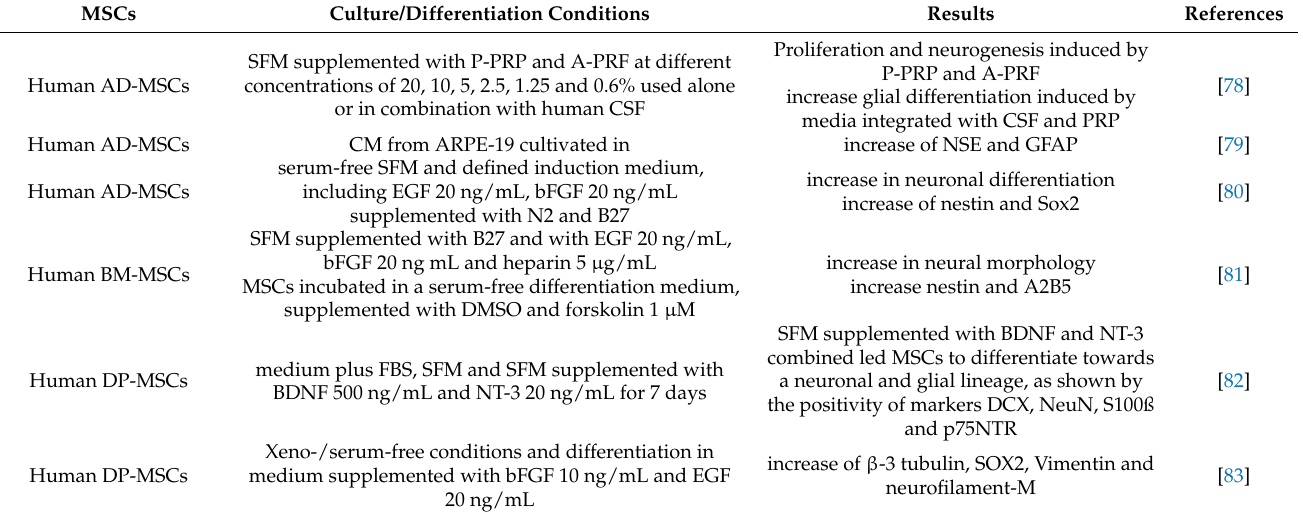
Table 5. Summary of the in vitro studies that reported the effects on MSCs cultivated in serum-free conditions with the supplementation of grown factors used alone or combined with chemical agents or